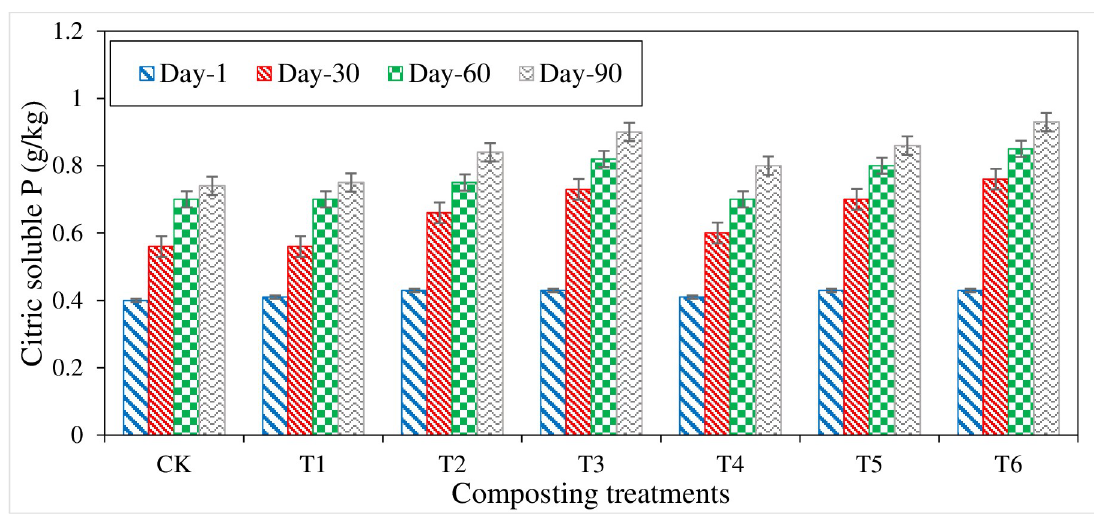
Fig 10. Variations in citrate soluble P (CSP) measured from different composting